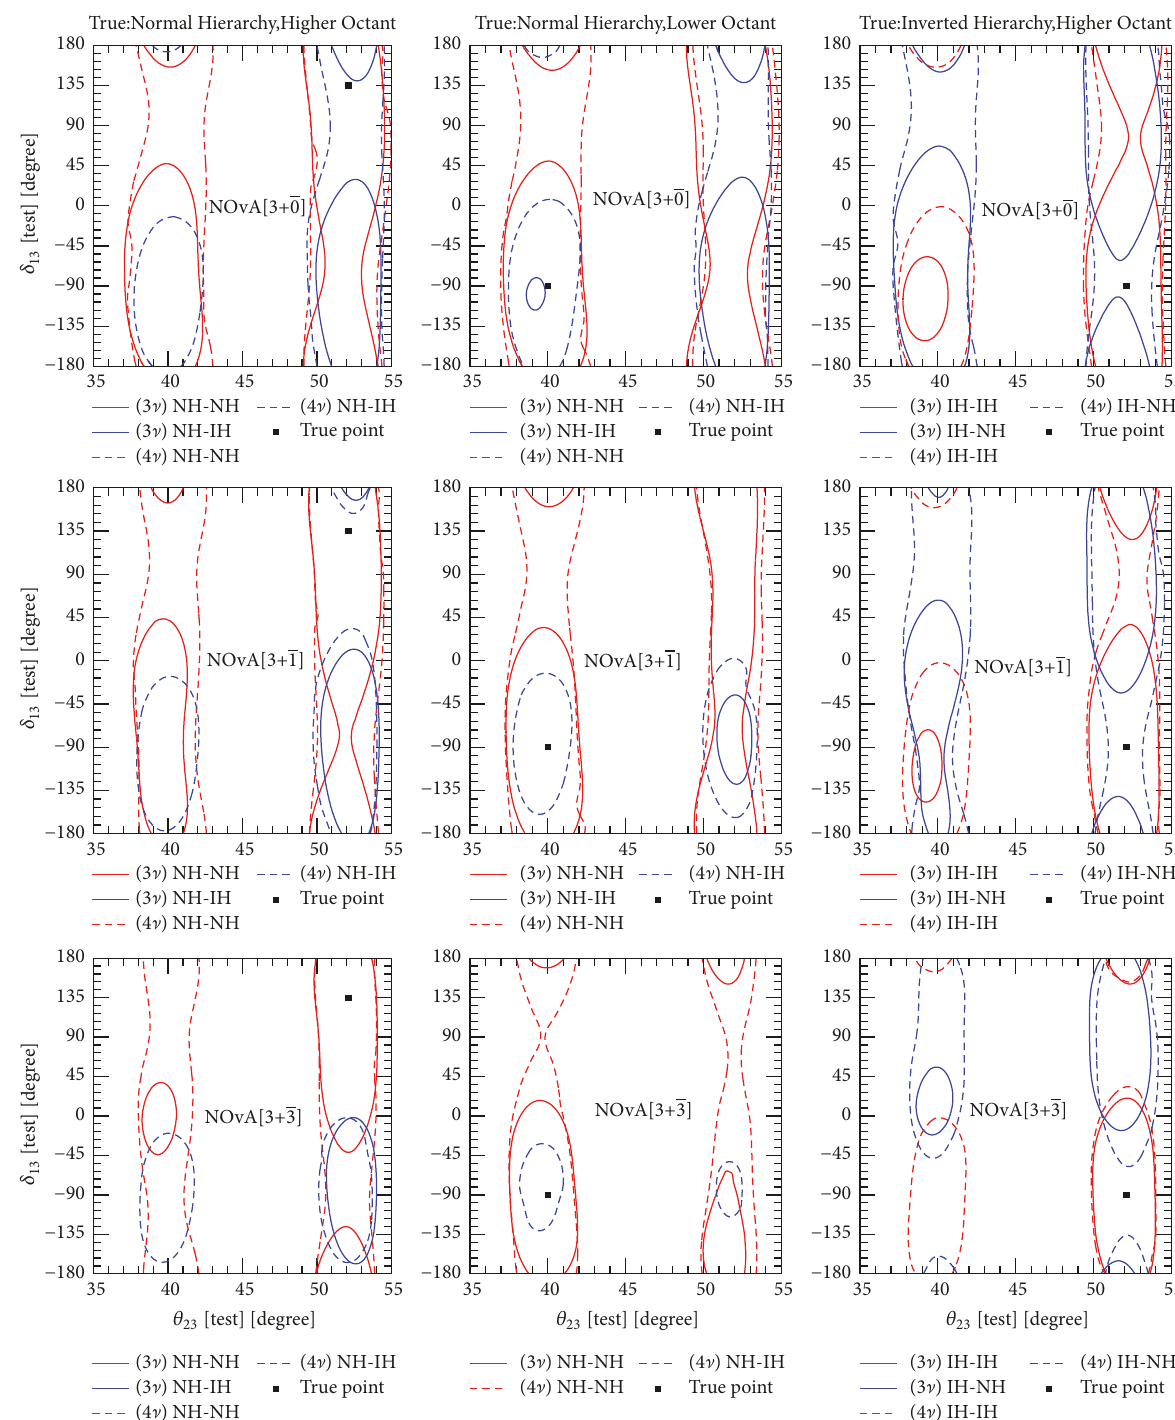
Figure 3: Contour plots of allowed regions in the test plane, 𝜃 23 versus 𝛿 13 , at 90% C.I with top, middle, and bottom rows for NO ] A runs of 3 + 0, 3 + 1 , and 3 + 3 years, respectively.